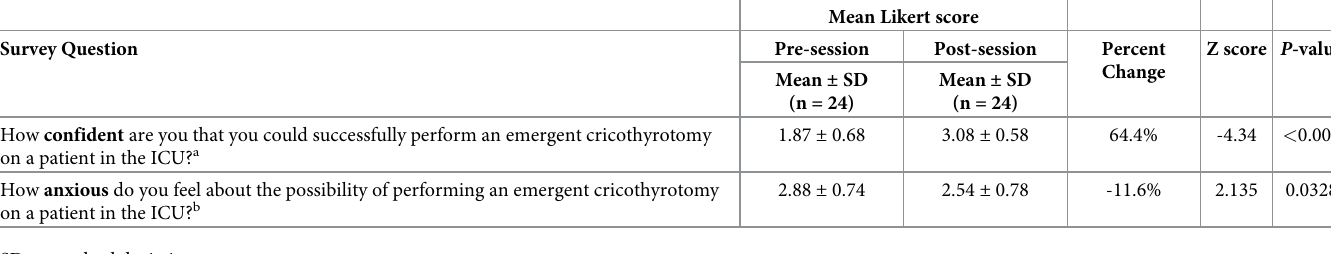
Table 4. Quantitative pre- and post-session survey